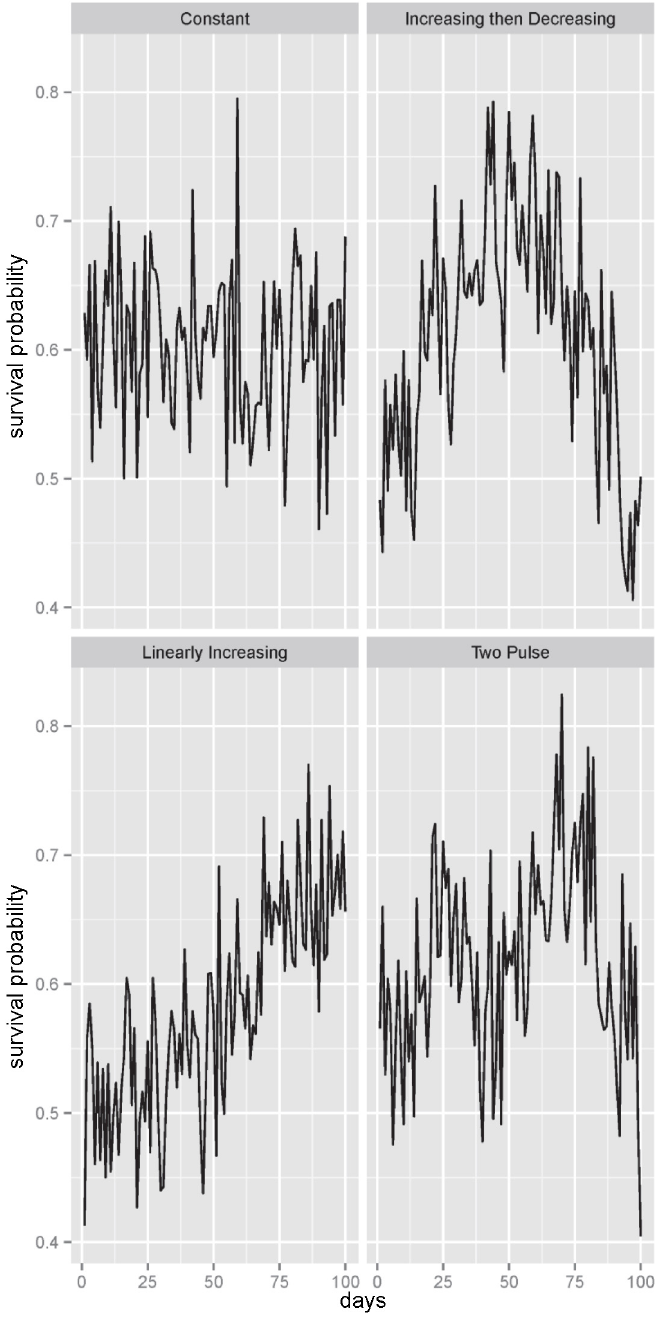
Fig 2. Survival probability patterns, each with added day-to-day fluctuations ( σ = 0.06). All survival probabilities are generally between 0.4 and 0.8, and the seasonal average survival probability is about 0.6 for all